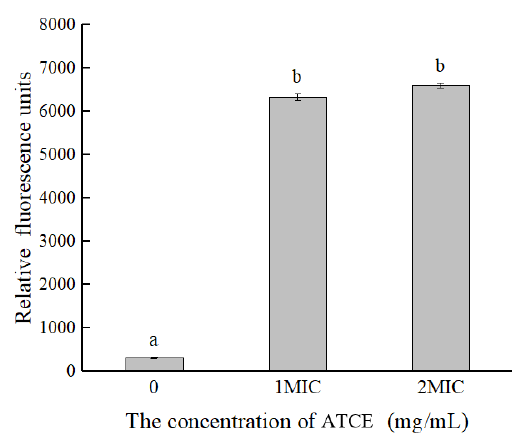
Figure 2. Differences in membrane potentials of S. aureus ATCC 13565 after treatment with ATCE at 0, 1, and 2 MIC. Values denote the means of triplicate measurements. Error bars represent standard deviation ( n = 3). Different lowercase letters (a,b) represent significant differences ( p < 0.05).